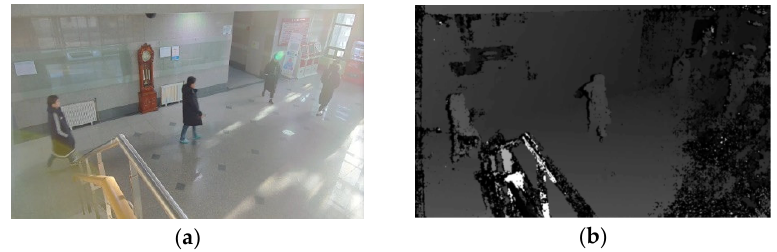
Figure 7. Depth map extraction: ( a ) color image, and ( b ) disparity map.